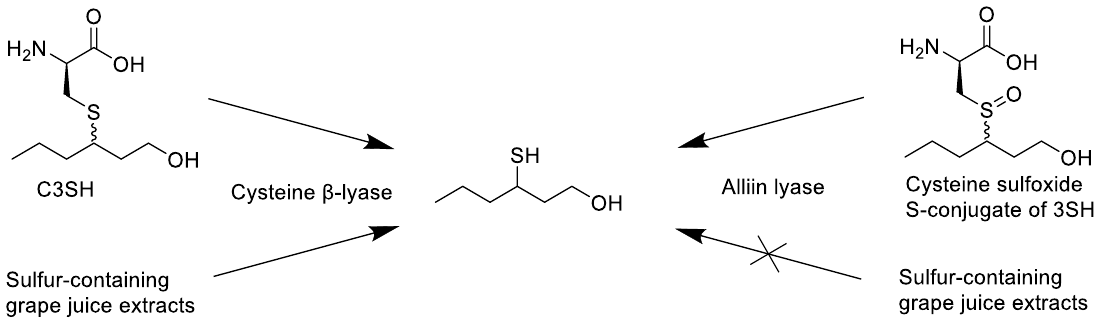
Scheme 1. Simplified visual representation of the work of Tominaga et al. [22] , elucidating the nature of the cysteine conjugate precursor by an enzyme